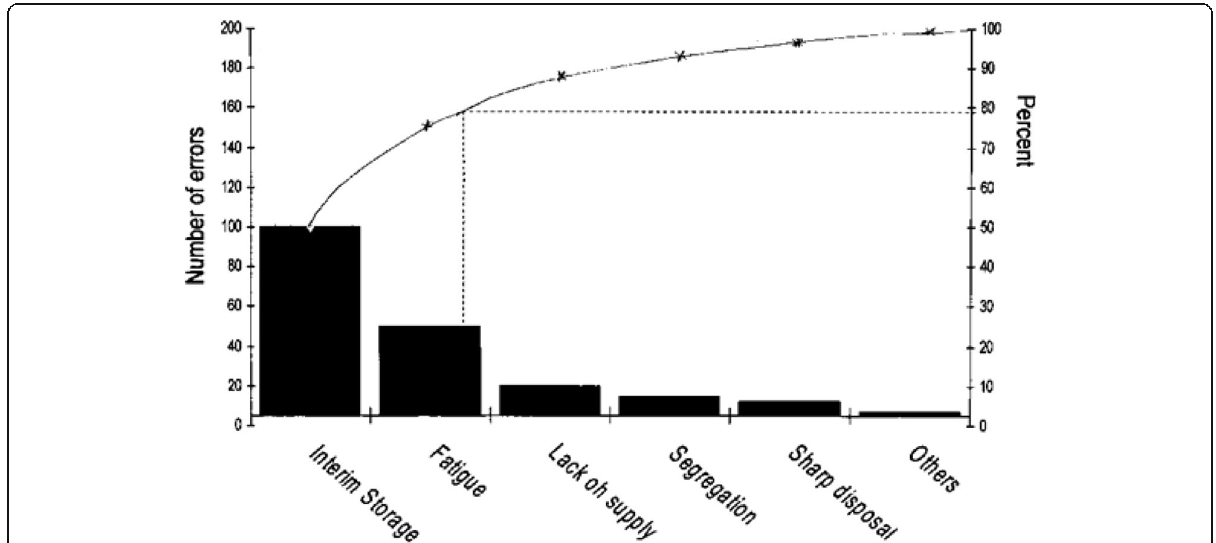
Fig. 2 Pareto diagram of figure and percentage of risk score in waste management process. It shows the (cumulative-percent) of the total effect of the ranked causes of the problem to identify the vital few root causes which contribute to 80% of the problem